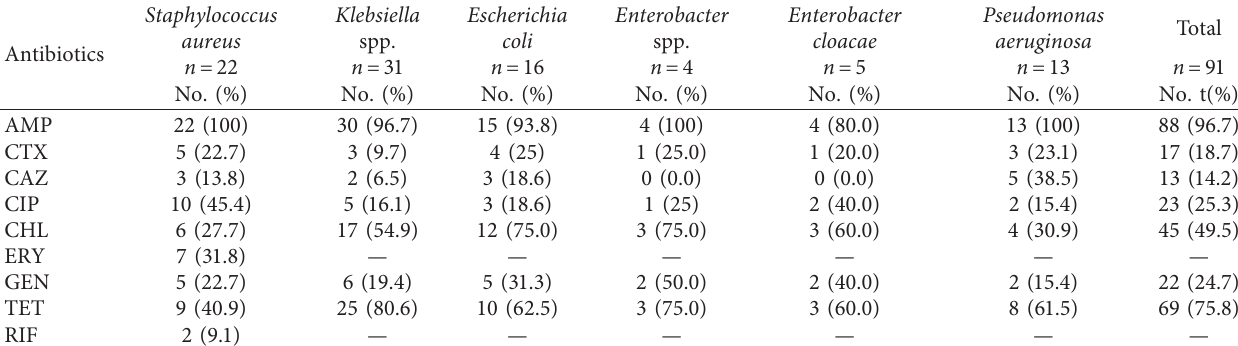
Table 3: Antibiotic susceptibility patterns of pathogenic bacteria